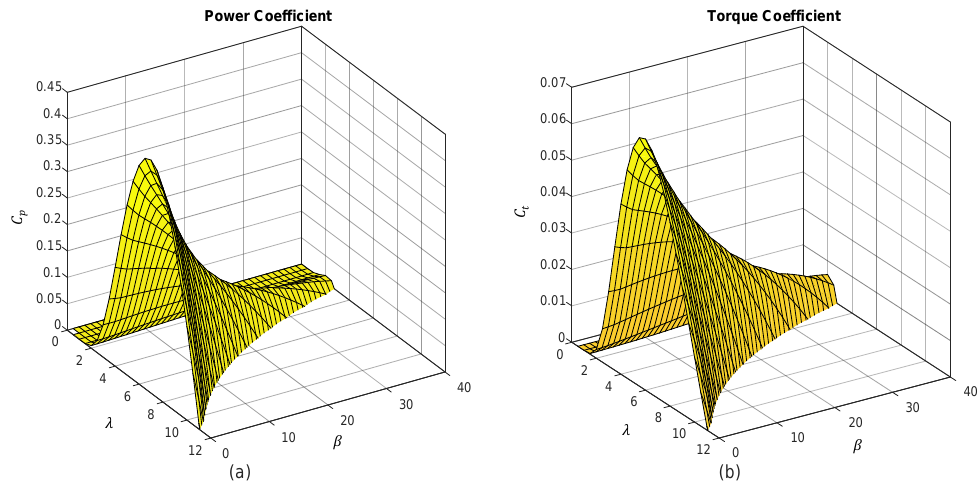
Figure 17. Coefficient proposed by Shi, Zhu, Cai, Wang, and Yao [49,50], with variations of 𝜆 and 𝛽 ; ( a ) power coefficient, ( b ) torque coefficient.